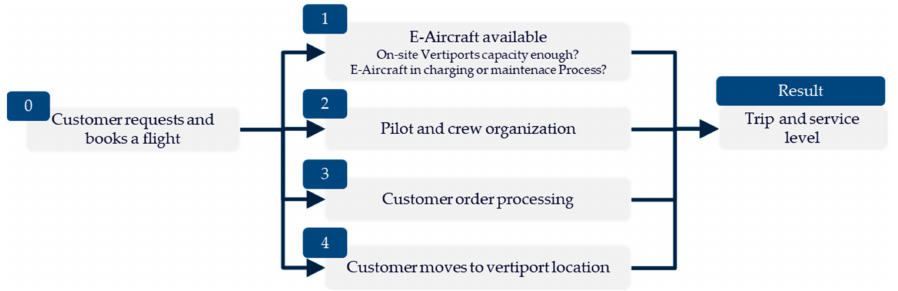
Figure 7. On-Demand Air Mobility